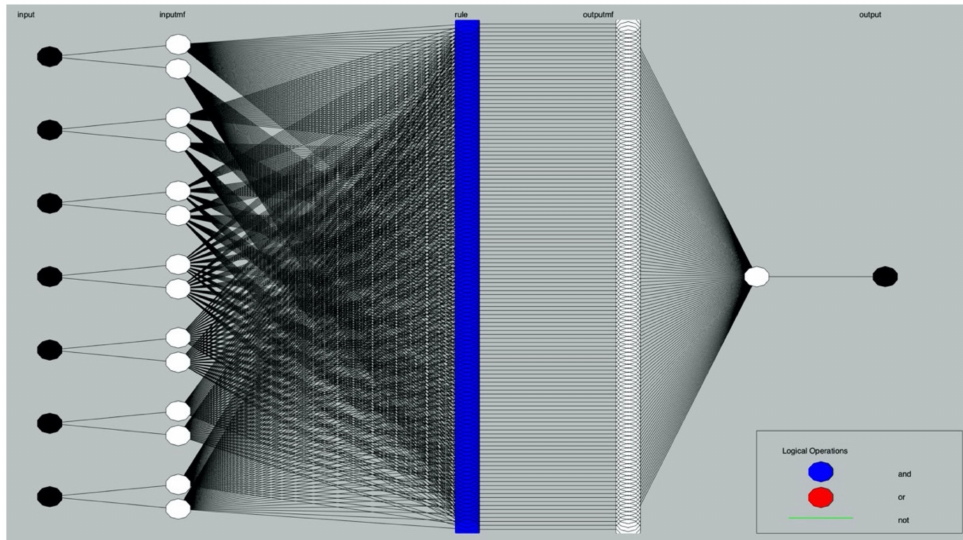
Figure 4. Structure of neuro-fuzzy inference system (ANFIS).